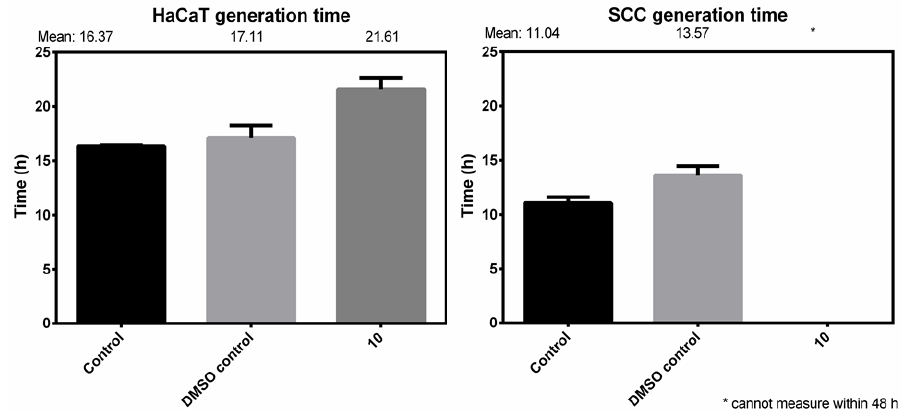
Figure 5. E ff ect of DMSO and compound 10 on the generation time of HaCaT and SCC cells. *: No division within 48 h.